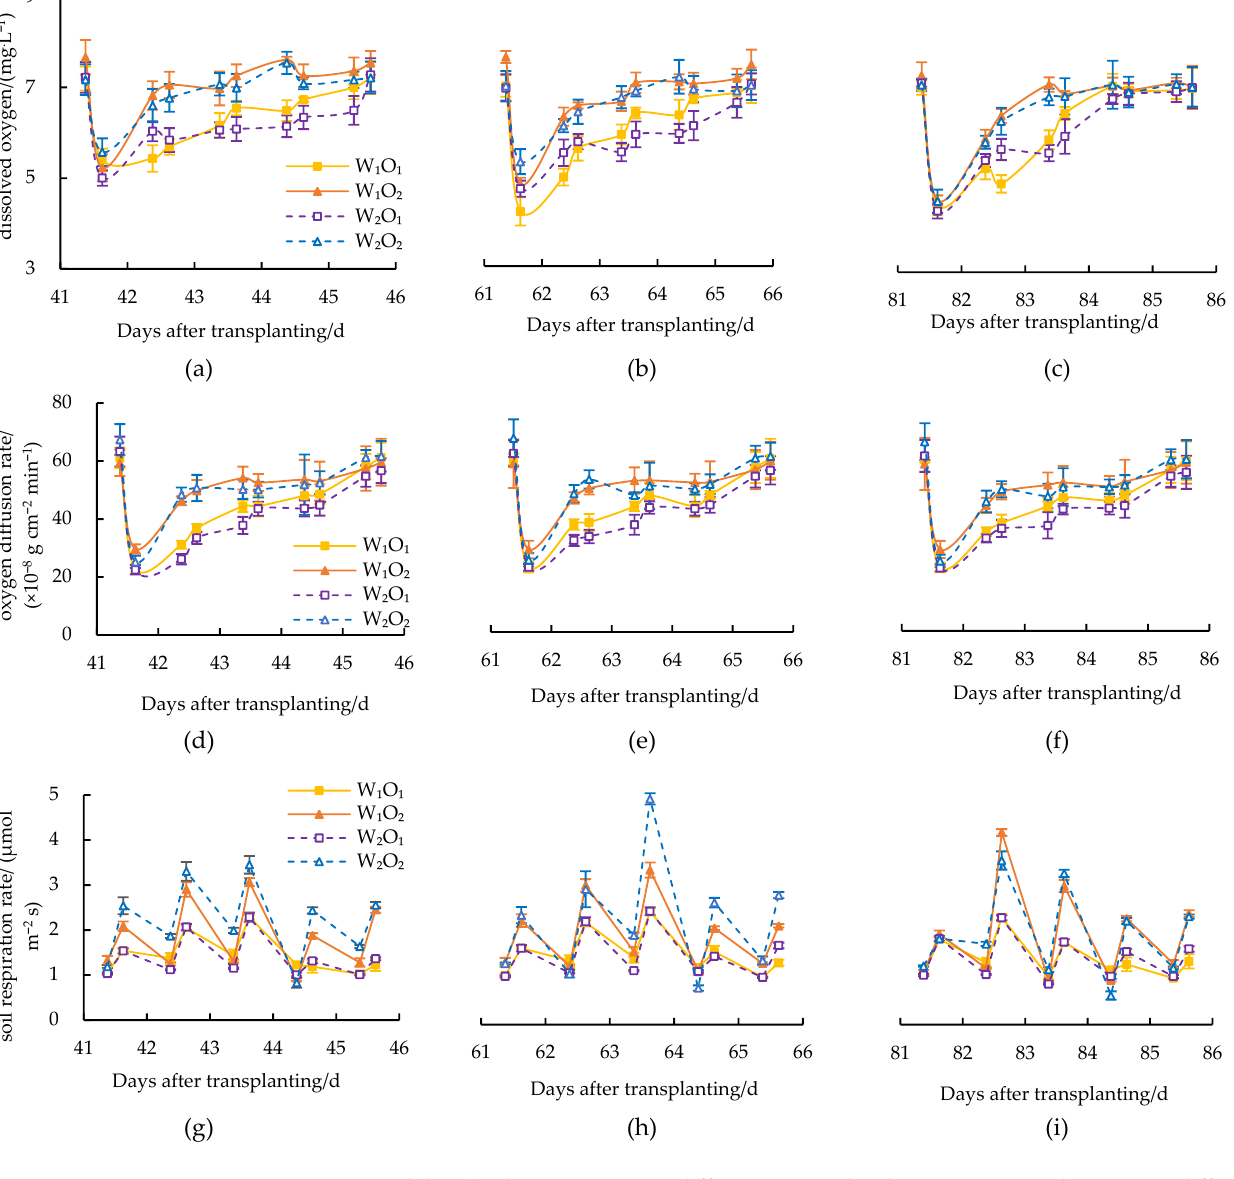
Figure 2. Soil dissolved oxygen, oxygen diffusion rate and soil respiration rate dynamics at different growth periods. ( a ) Flowering and fruit-setting stage, ( b ) Fruit expansion stage, ( c ) Maturation stage, ( d ) Flowering and fruit-setting stage, ( e ) Fruit expansion stage, ( f ) Maturation stage, ( g ) Flowering and fruit-setting stage, ( h ) Fruit expansion stage, and ( i ) Maturation stage.